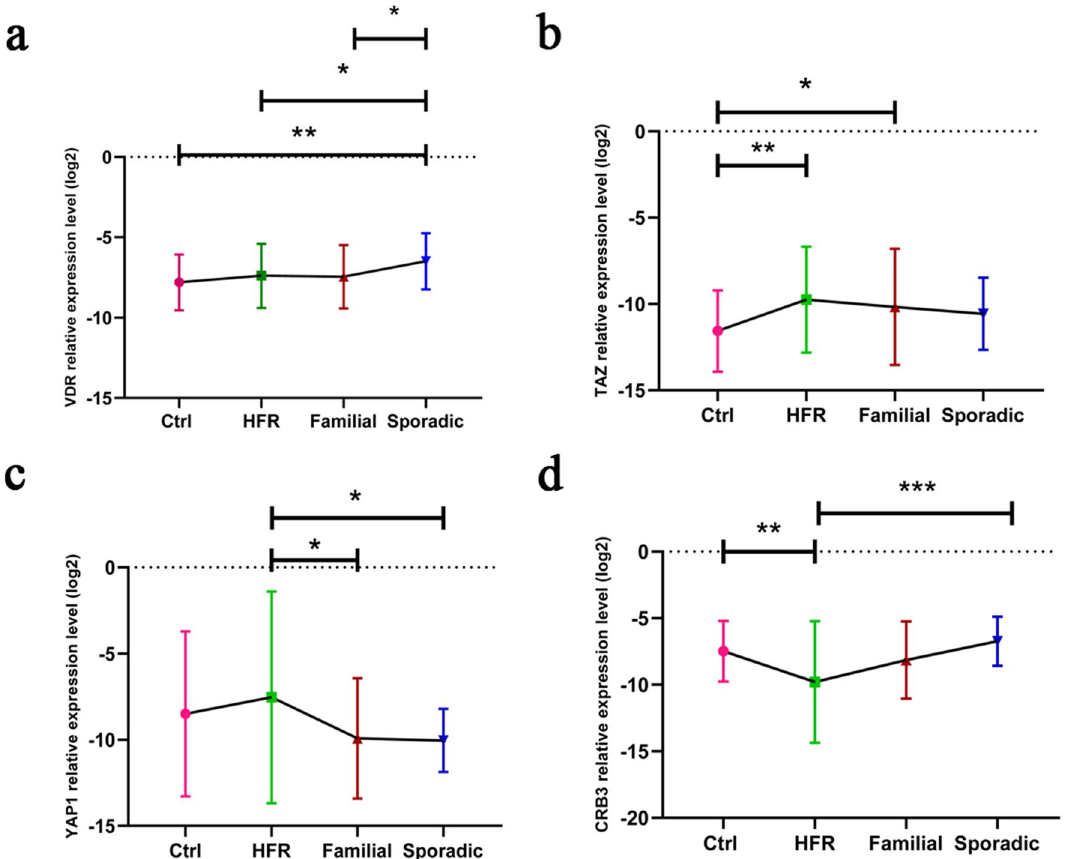
Figure 1. Differential expression level of ( a ) VDR , ( b ) TAZ , ( c ) YAP1 , and ( d ) CRB3 among genetically separated groups and control group. Ctrl = control group, HFR = healthy first-degree relatives of the familial group. Bars represent the standard error of the mean. (*p < 0.05, **p < 0.01, ***p < 0.001).